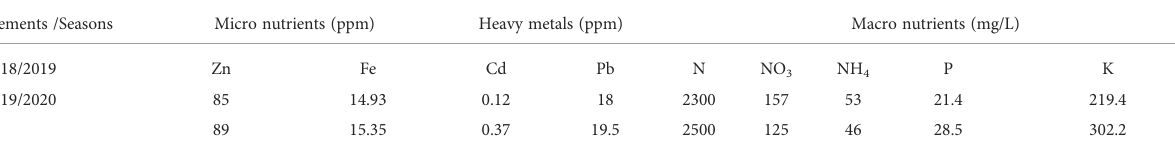
(Table 1). After fi ve minutes of seed surface sterilization with 2% sodium hypochlorite, the seeds were carefully washed and rinsed multiple times with sterile water. Before planting, the soil used in this experiment was fertilized with calcium super phosphate fertilizer (P 2 O 5 15.5%) that was added at the rate of 5 g/kg. Six healthy seeds were planted in each pot on the 19 th of September 2018/2019 and on the 17 th of September 2019/2020 seasons respectively. Under ideal conditions, in aerated full-nutrient media in plastic pots (Sandalio et al., 2001). The treatments were: control soil or Cadmium (CdCl 2 ) treated soil at low concentration (50 mg/kg soil) and high concentration (100 mg/kg soil). Then silicon or Si(OH) 4 (Sigma Chemical Company, St. Louis, MO, USA). Si treatments were introduced when seedlings were 25 days old at three concentrations of 100, 200, and 300 ppm Si. Plant foliar application was carried out two times using a one-hand pressure sprayer; the fi rst application was 25 days after planting and the second after 45 days from sowing (at vegetative and fl owering stages, respectively). The application was in the early morning when the stomata were open, allowing for better foliar penetration. Tween-20 was added at 0.1% (v/v) to applications as a surfactant to ensure optimal penetration into leaf tissues. The pots were then distributed into